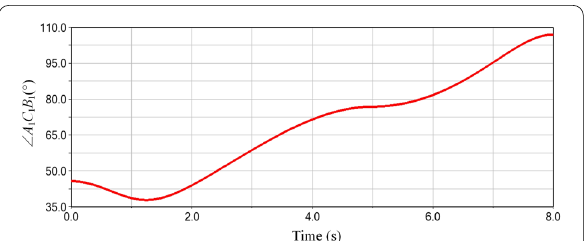
Figure 21 The simulation value of ∠ A 1 C 1 B 1 when the mechanism avoids singular position 1